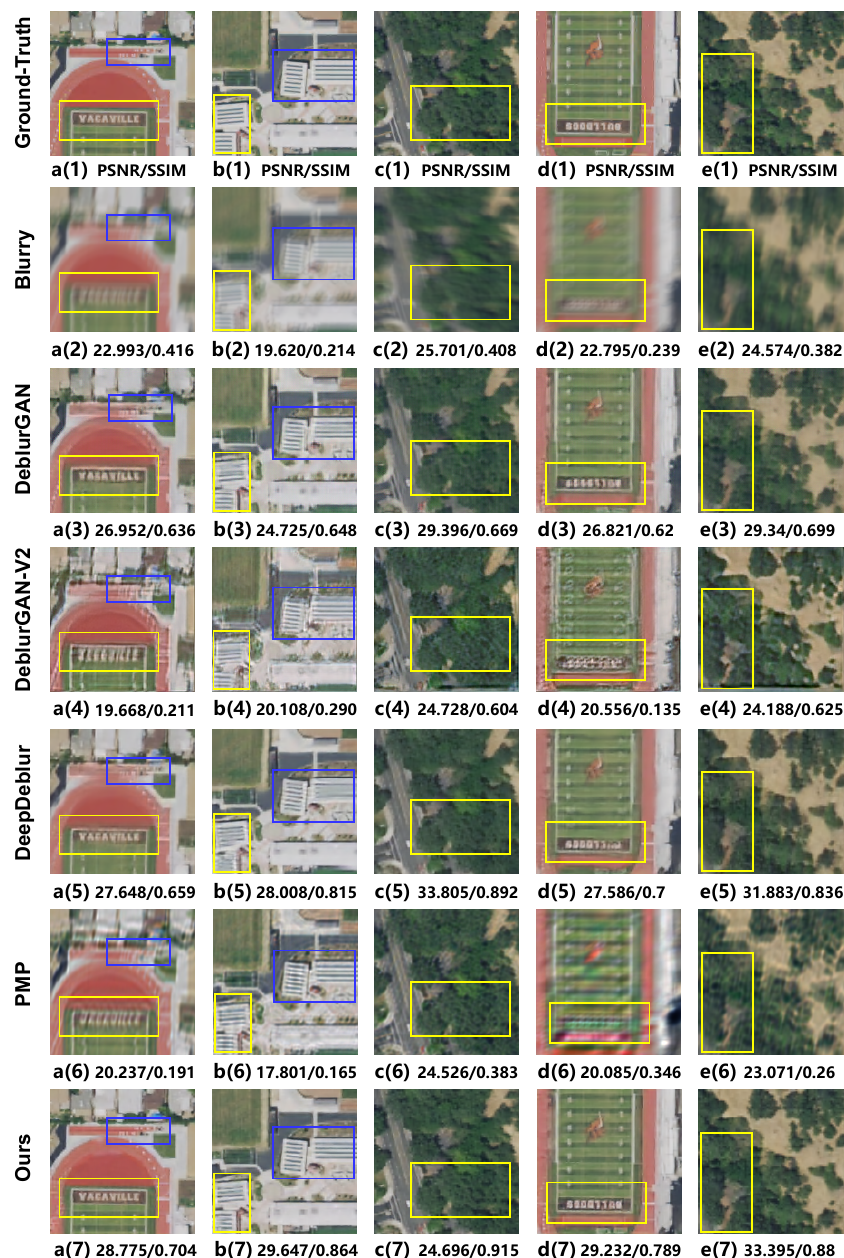
Figure 8. Visual comparison of images restored by different deblurring methods on the testing set. Furthermore, as shown in Figure 9, when the reference image is significantly different from the target image, the result restored by our algorithm are closer to the ground truth and do not have the redundant texture information of the reference